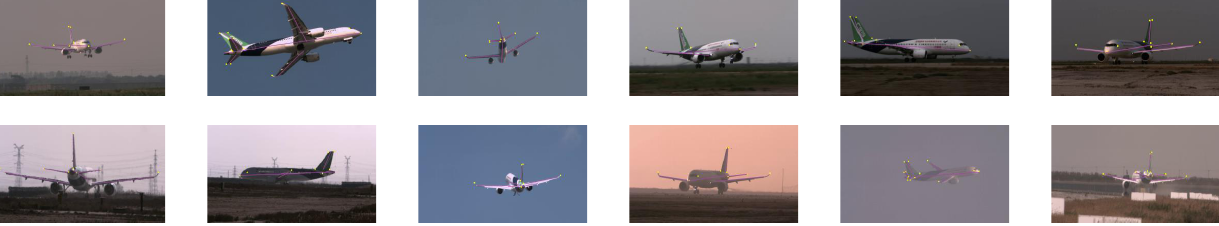
Figure 13. Qualitative results for the proposed method on the APE dataset. The yellow points are the keypoints and the purple segments are the